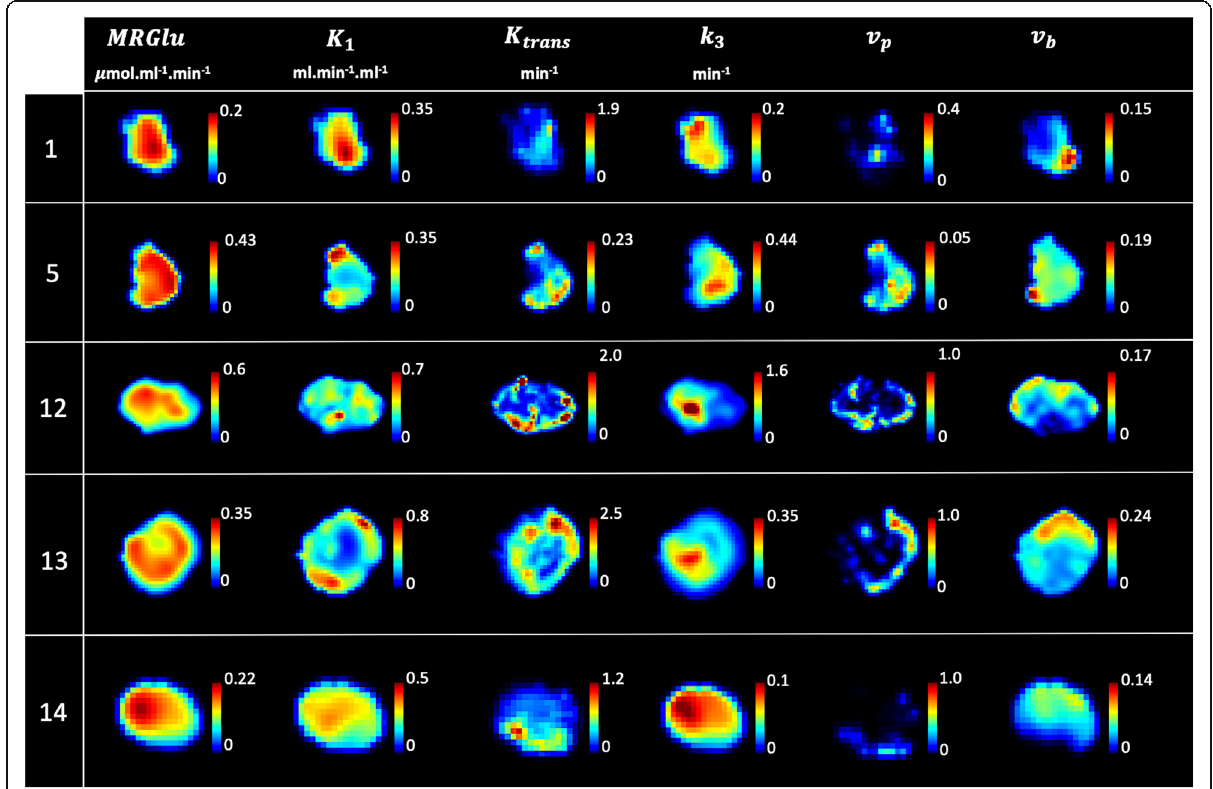
Fig. 6 Regional decoupling between perfusion/vascularization and metabolism. In all these tumors, whereas MRGlu appears relatively homogeneous, deep central hypoperfused/vascularized areas of variable sizes are visible (low K trans , v p , or v b ), mirrored by high metabolic enzymatic activity (k 3 ). This pattern is highly suggestive of hypoxic tumor areas, a well-known hallmark of cancer